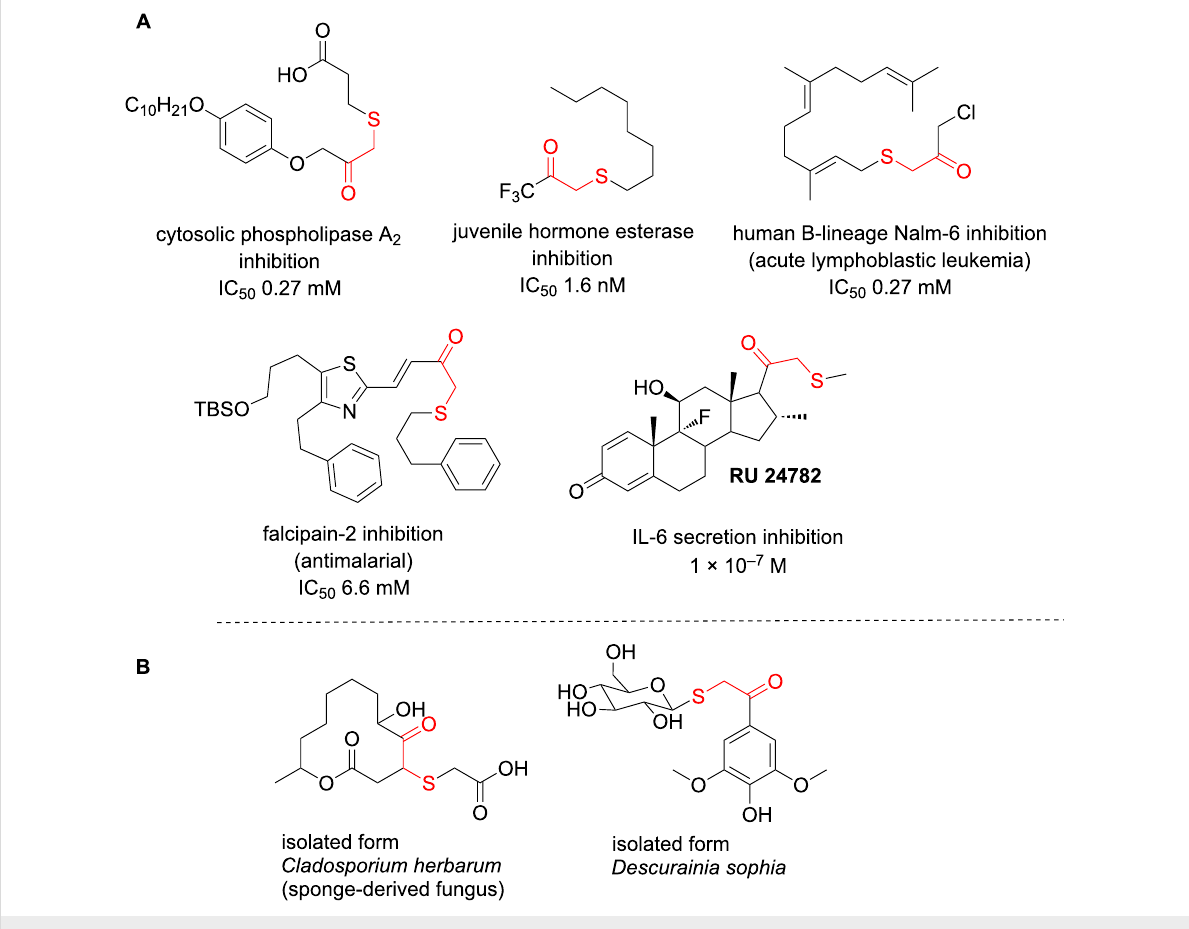
Figure 1: Selected examples of valuable β -ketosulfides. A: bioactive synthetic compounds, B: natural products.